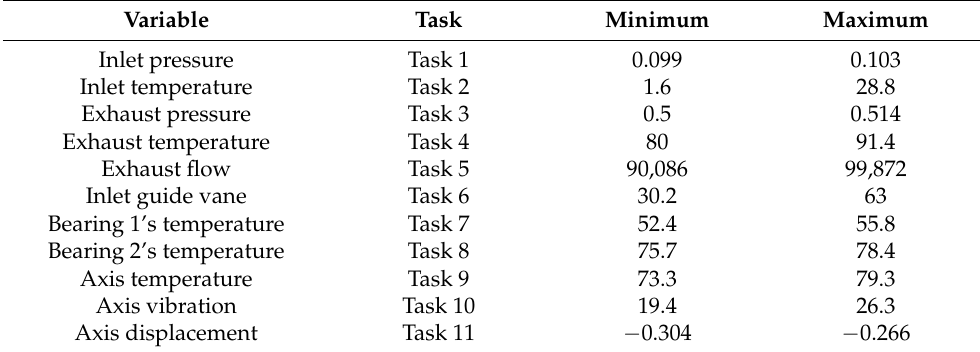
Table 5. Details of tasks acquired from the centrifugal